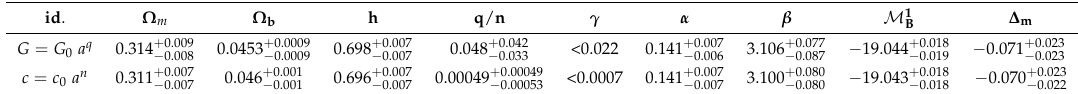
Table 1. Observational parameters of the models under